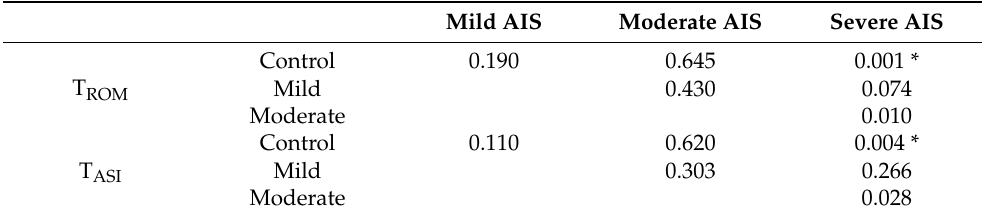
Table 4. Multiple comparison test of T ROM and T ASI between mild, moderate, and severe AIS patients and controls.